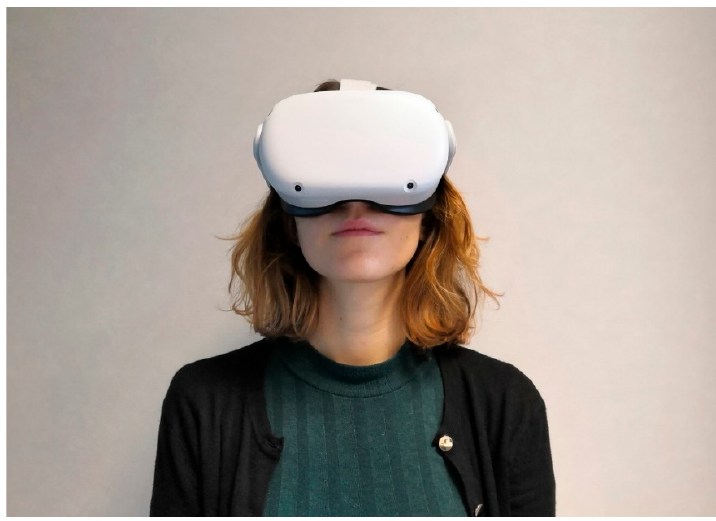
Figure 2. The HMD to be used in the experimental group and the control